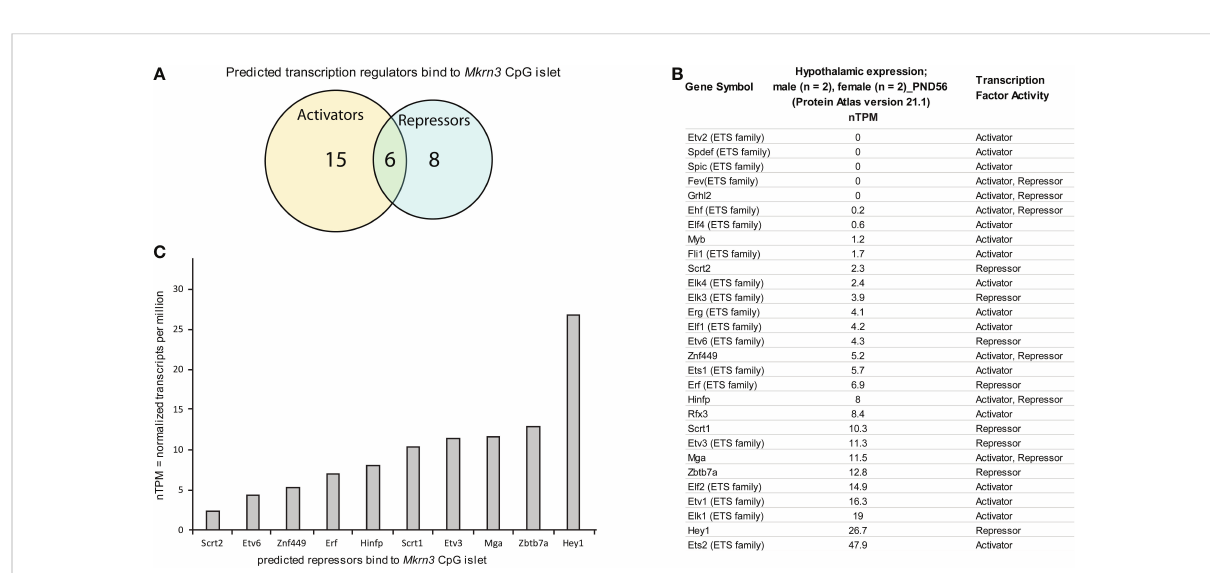
FIGURE 5 In silico analysis of transcription factor binding sites at Mkrn3 CpG islet. (A) Venn diagram showing the predicted transcription activators and repressors bind to Mkrn3 CpG islet. (B) Hypothalamic expression at post-pubertal stage (PND56) of the predicted transcription regulators bound to Mkrn3 CpG islet. RNA sequencing data of mice (two males and two females) at PND56 were extracted from the Brain Atlas resource [part of the Human Protein Atlas (58)]. (C) Bar graphs showing the hypothalamic expression of predicted repressors bind to Mkrn3 CpG islet at post- pubertal stage (PND56). nTPM: normalized Transcripts Per